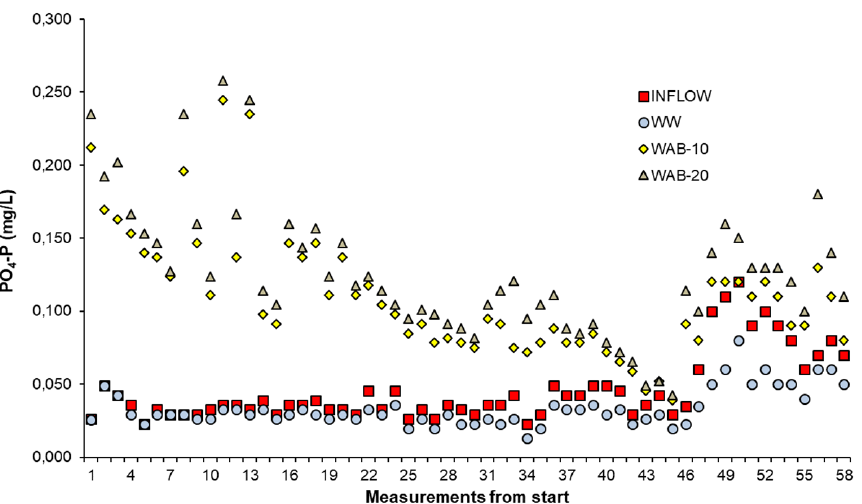
Figure 6. Dynamics of PO 4 -P concentrations at the outlets of bioreactors with different fillers. The inceptive cases are neglected in the graph.